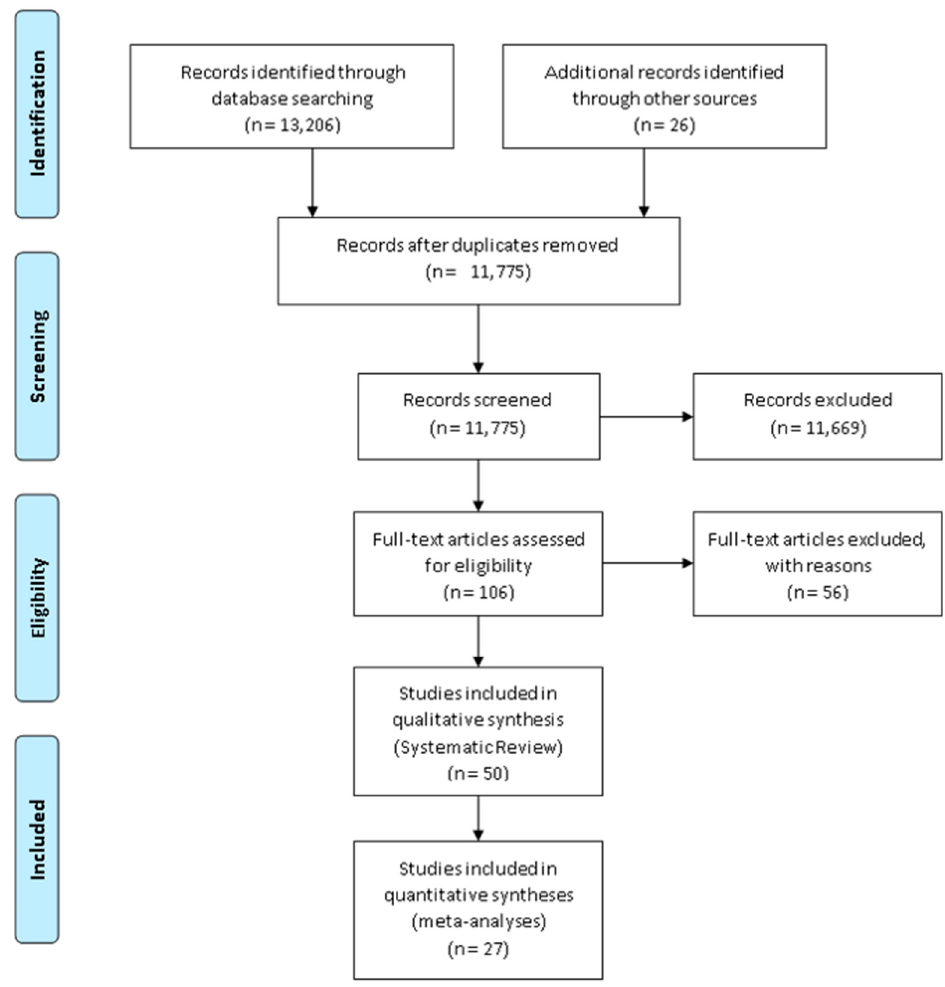
Figure 2 . PRISMA Flow Diagram . Figure 2. PRISMA Flow